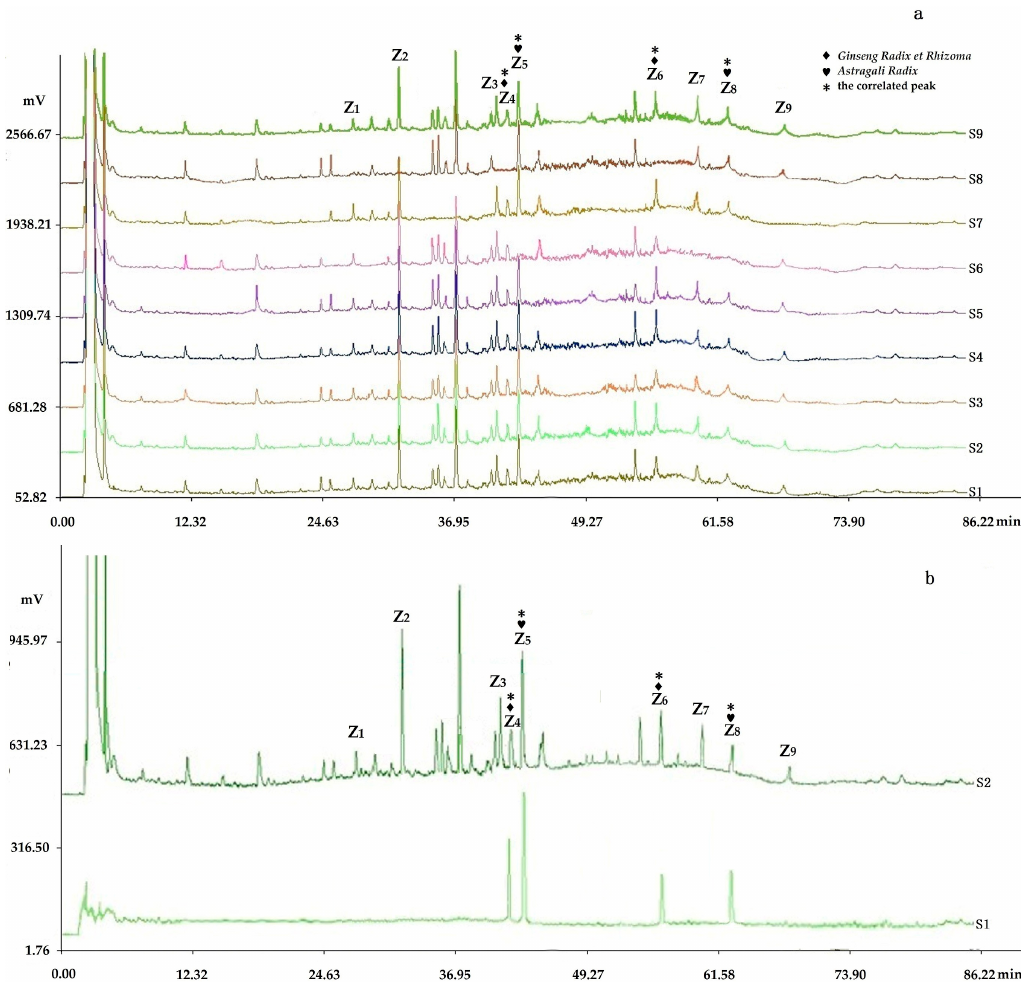
Figure 8. Chromatogram comparing the fingerprints analyzed by chromatographic condition II (HPLC-ELSD) with negative control samples and reference standard samples: ( a ) S1–S8 were respectively the negative sample without Hirudo , without Curcumae Rhizoma , without Cervi Cornu Pantotrichum , without Fritillariae Thunbergii Bulbus , without Sparganii Rhizoma , without Astragali Radix , without Epimedii Folium , and without Ginseng Radix et Rhizoma , in which peaks 4 and 6 were from Astragali Radix ; peaks 5 and 8 were from Ginseng Radix et Rhizoma by comparing with the negative control solutions (S1–S8); ( b ) S2 and S1 were respectively the fingerprints of the sample solution and reference standard solution, in which four peaks were respectively verified by comparing with the reference standard substance: peak 4, ginsenoside Rc; peak 5, astragaloside; peak 6, ginsenoside Rd; peak 8, astragaloside II.